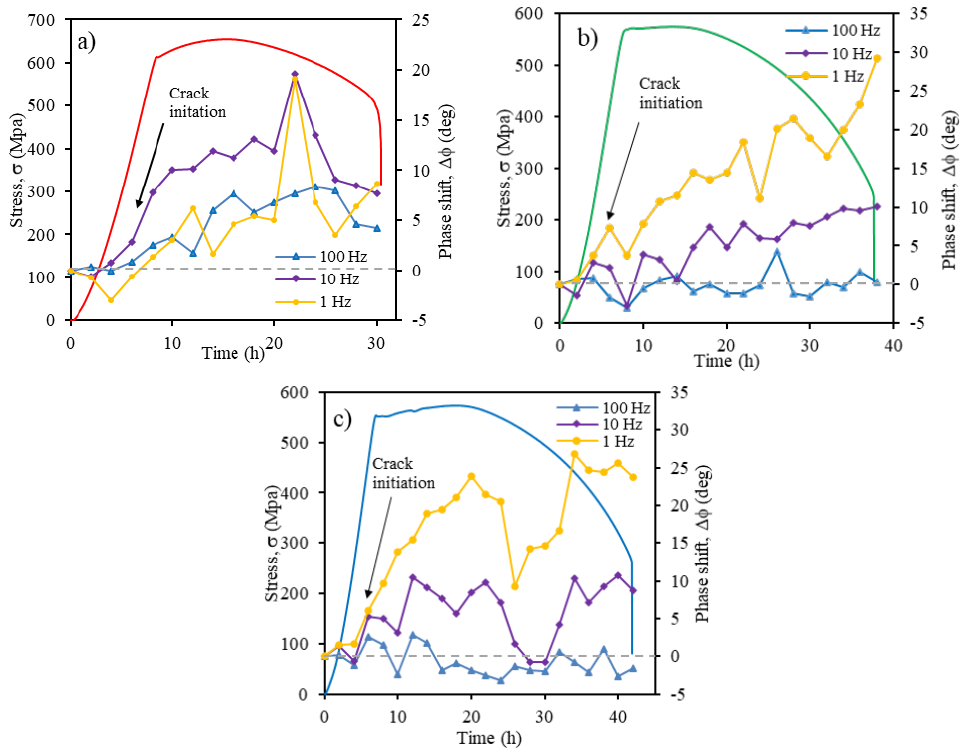
Figure 8. Evolution of Δφ value obtained during SSRT at different frequencies (1, 10 and 100 Hz) for X70 steel in NS4 solution at different pH values: ( a ) pH 3, ( b ) pH 8 and ( c ) pH 10.